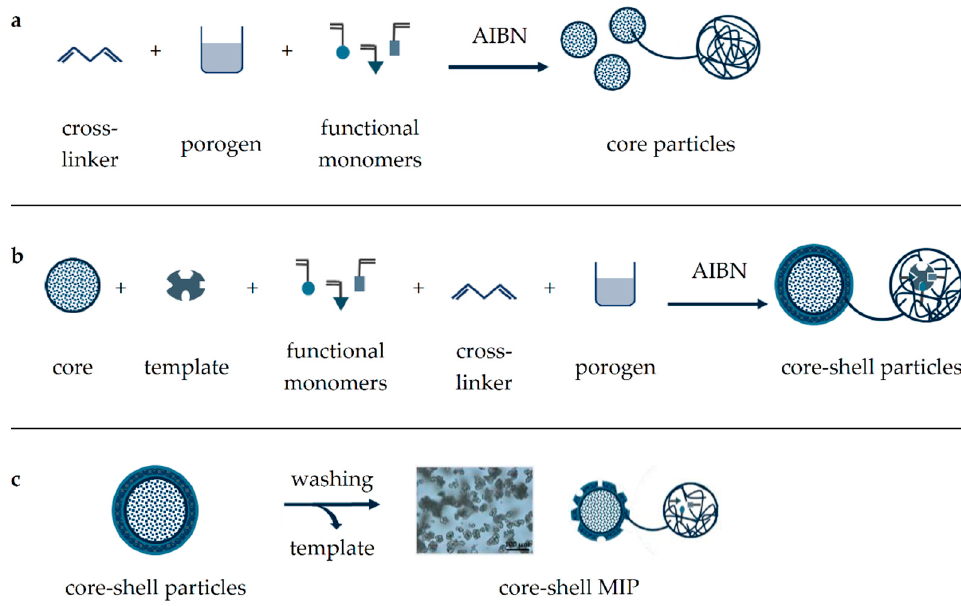
Figure 2. Schematic illustration of core-shell MIP synthesis. Core particles are obtained through heat-induced polymerization of functional monomers using a cross-linker ( a ), this step can be repeated to increase core size. Then, core particles are mixed with the template and functional monomers for MIP-shell formation ( b ), which is released by thorough washing ( c ).